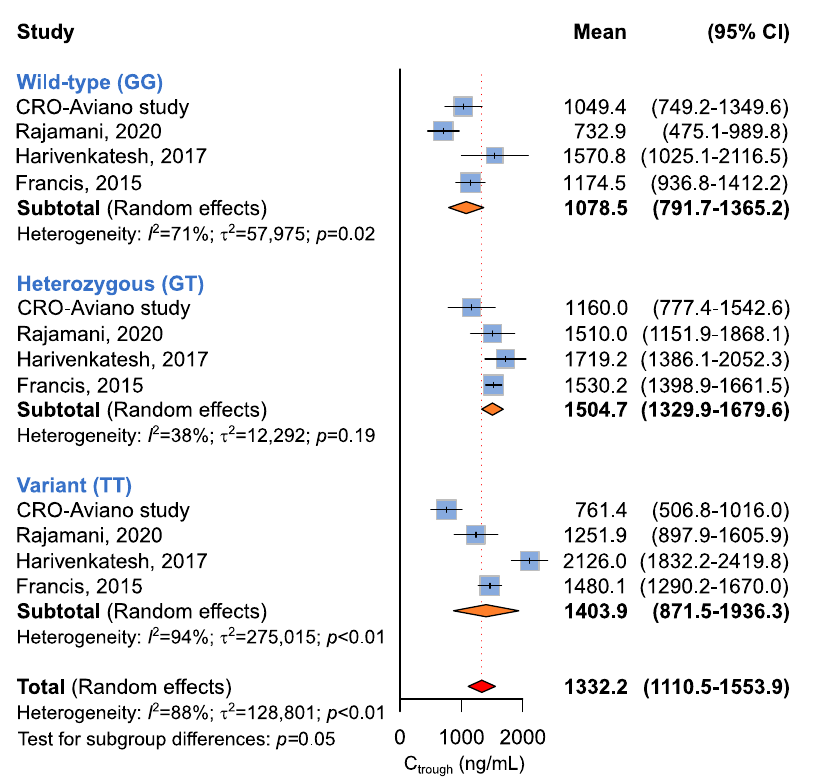
Figure 3 . Forrest plots for the association between ABCB1 c.2677G>T and imatinib C trough levels for individual genotypes (allelic model) [14,17,18].